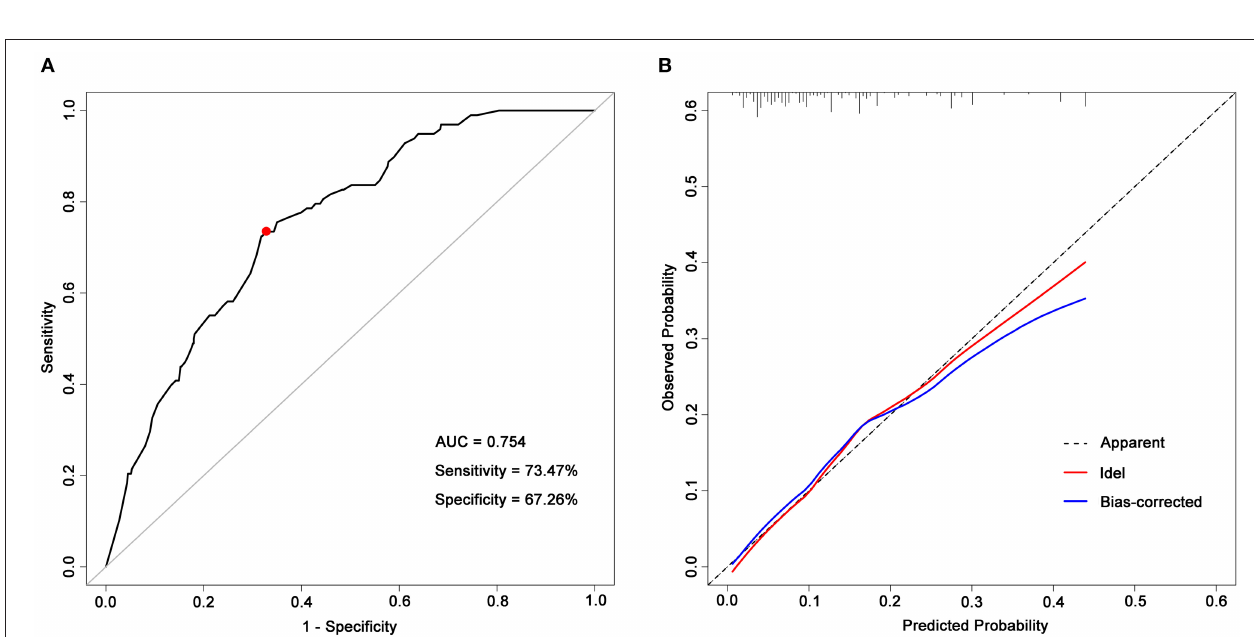
FIGURE 1 | Forest plot for each predictor. The odds ratio for each predictor is presented by a square, and the confidence interval is presented by a horizontal line. Severe TBI + C, severe TBI with conservative treatment; severe TBI + C, severe TBI with surgery operation; CI, confidence intervals; OR, odds ratio.